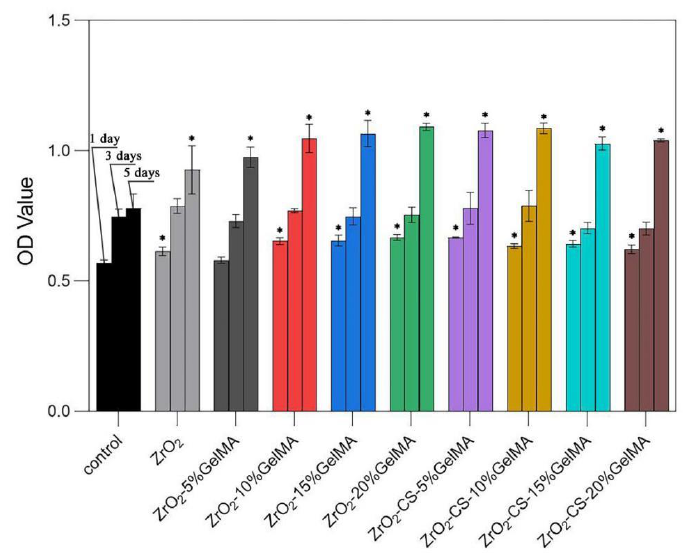
Figure 9. Proliferation performances of porous zirconia scaffolds with composite scaffolds, * p < 0.05, compared to control group. compared to control